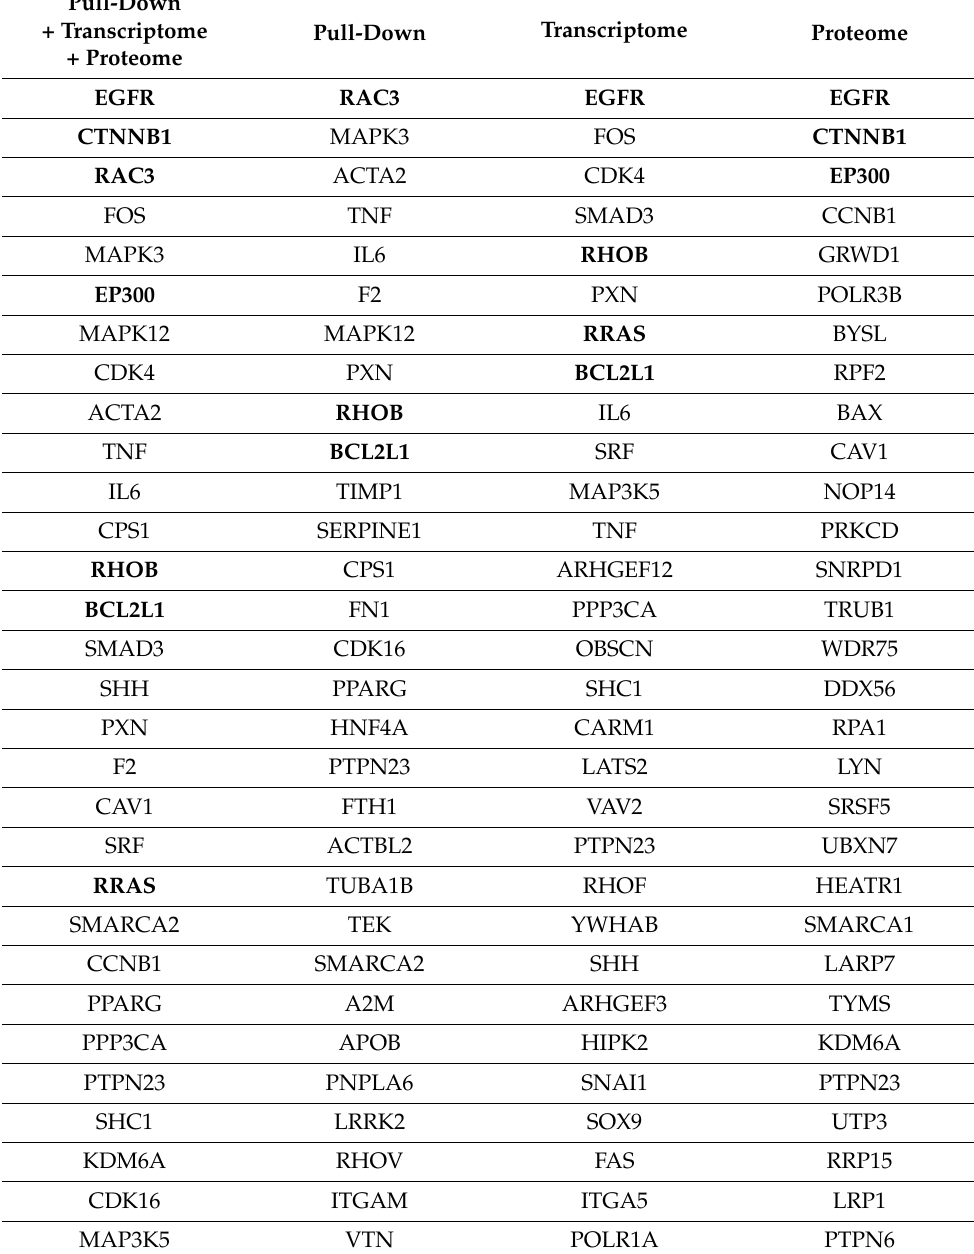
Table 1. Top 30 most-connected hubs in the PPI